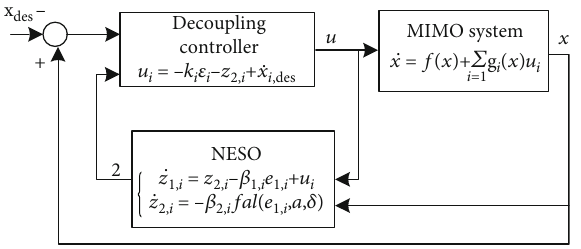
Figure 3: Block diagram of a NESO-based decoupling